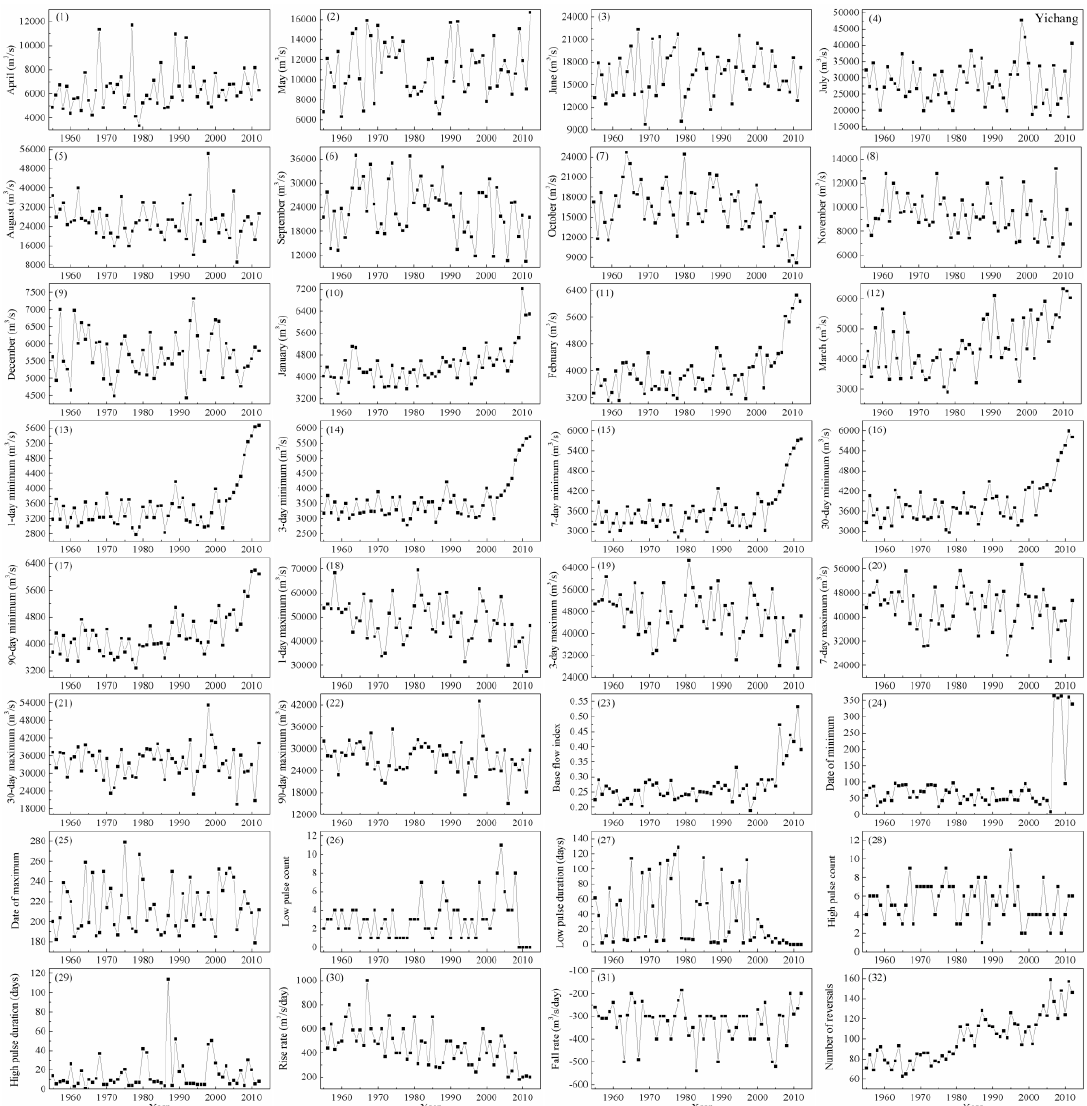
Figure 5. IHA series of the Yichang station.